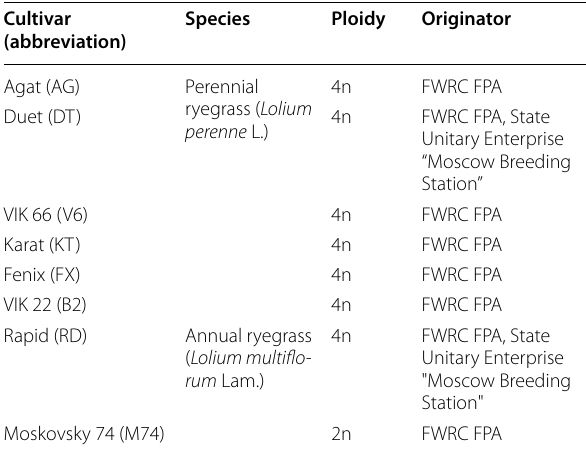
Table 1 The studied cultivars of perennial and annual ryegrass Cultivar Species (abbreviation)